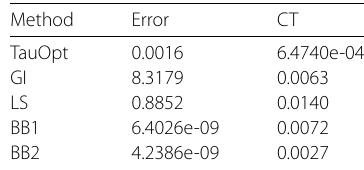
Table 4 Error & CT for Ex. 4.4